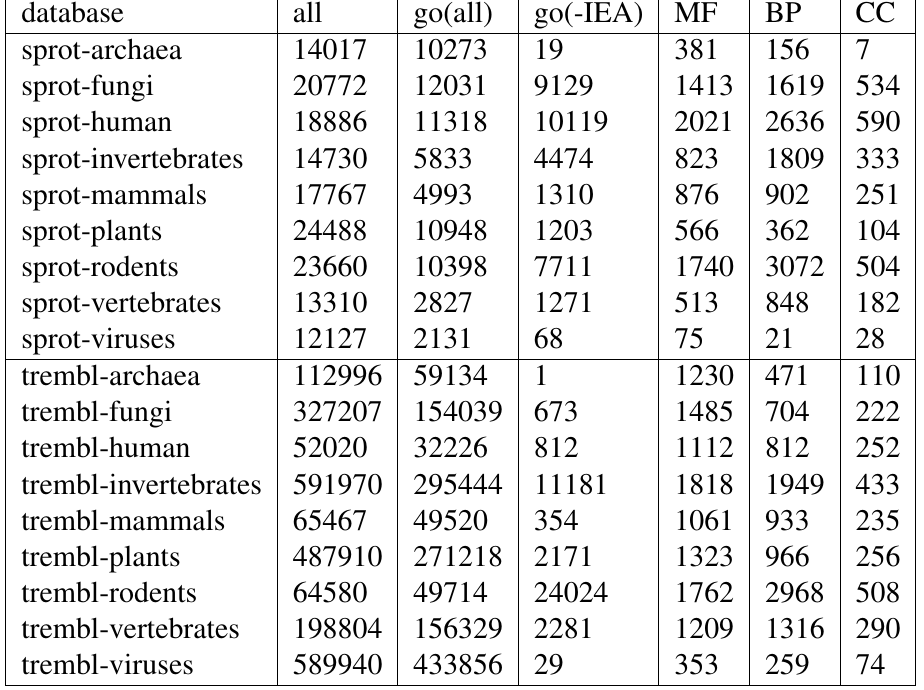
Table 2: GOblet Databases (April 2008). Number of proteins, GO annotated proteins (go), GO an- notated proteins without electronically annotated ones (go(-IEA)), and number of GO terms from all annotated proteins in the di ff erent GO categories molecular function (MF), cellular component (CC) or biological process